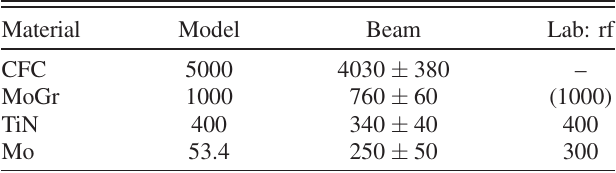
TABLE III. Comparison of the measured and expected resis- tivities (n Ω m). In the rf test, the materials are measured relative to MoGr, which is assumed to have the nominal